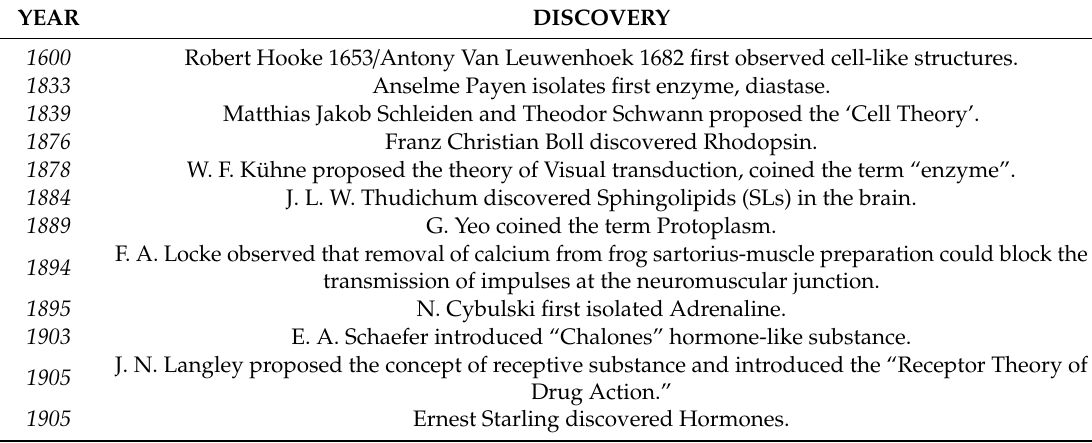
Table 2. Timeline of major discoveries in the field of cell